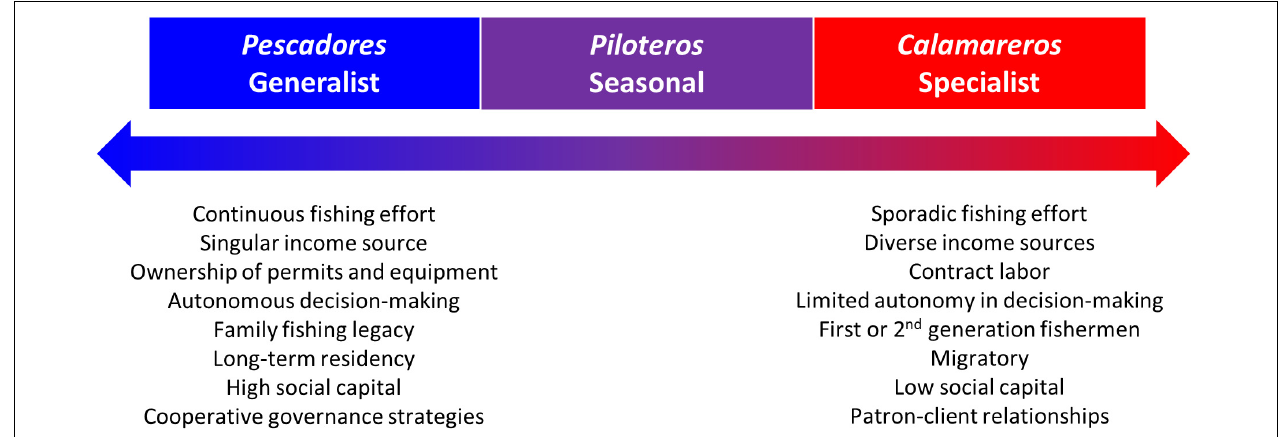
FIGURE 3 | Small-scale fisheries (SSF) livelihood continuum across coastal fishing communities in the Central Gulf of California.